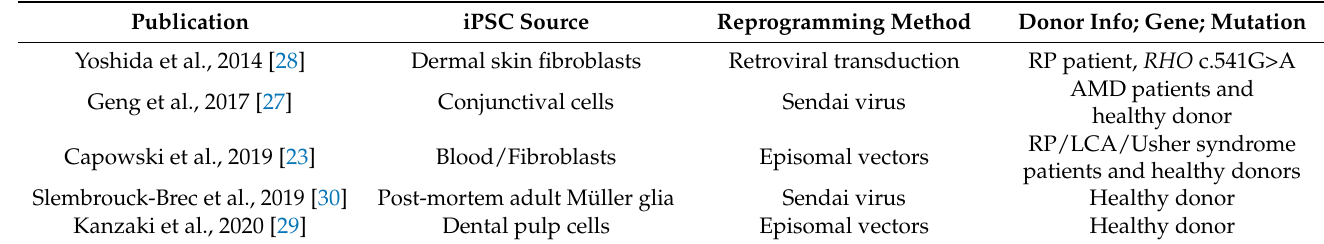
Table 1. Sources of healthy donor or patient cells for iPSC